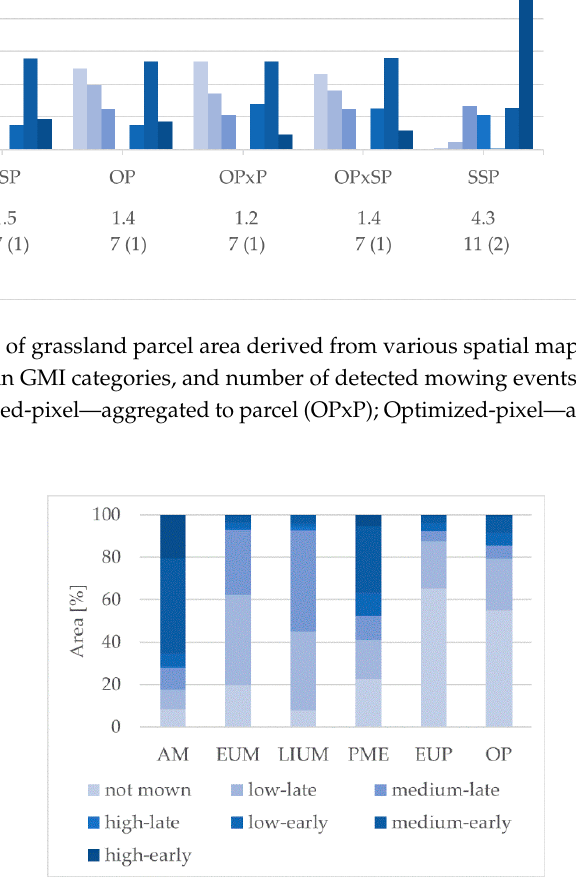
Figure 10. Percentage of study area in each category of the grasslands mowing index for the reference experiment (optimized-shrunken-parcel) within selected agricultural land use types. The marginal agricultural land use types were not included. artificial meadows (AM); extensively used meadows (EUM); less intensively used meadows (LIUM); permanent meadows (PM); extensively used pastures (EUP); OP, other pastures (pastures at farm